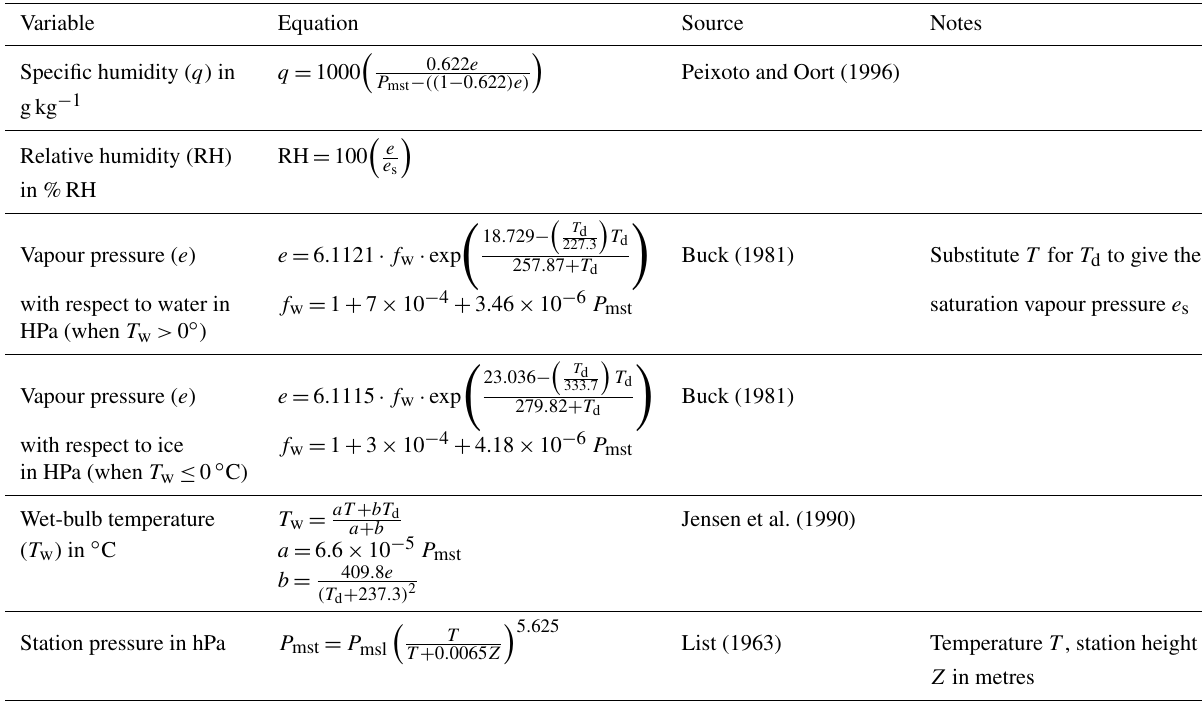
Table 5. Humidity formulae used in HadISD v2.0.0. as in HadISDH v2.0.0 (Willett et al., 2014). Variable